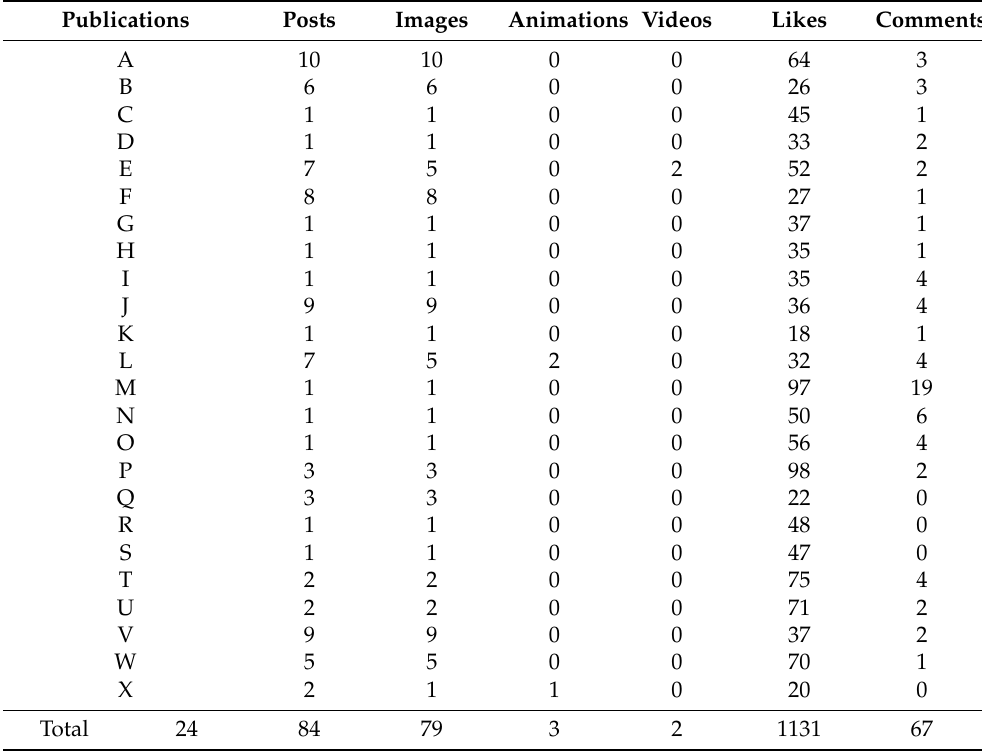
Table 4. Results of students’ posts on Instagram about Table 3. Results of students’ posts on Instagram about SDGs.